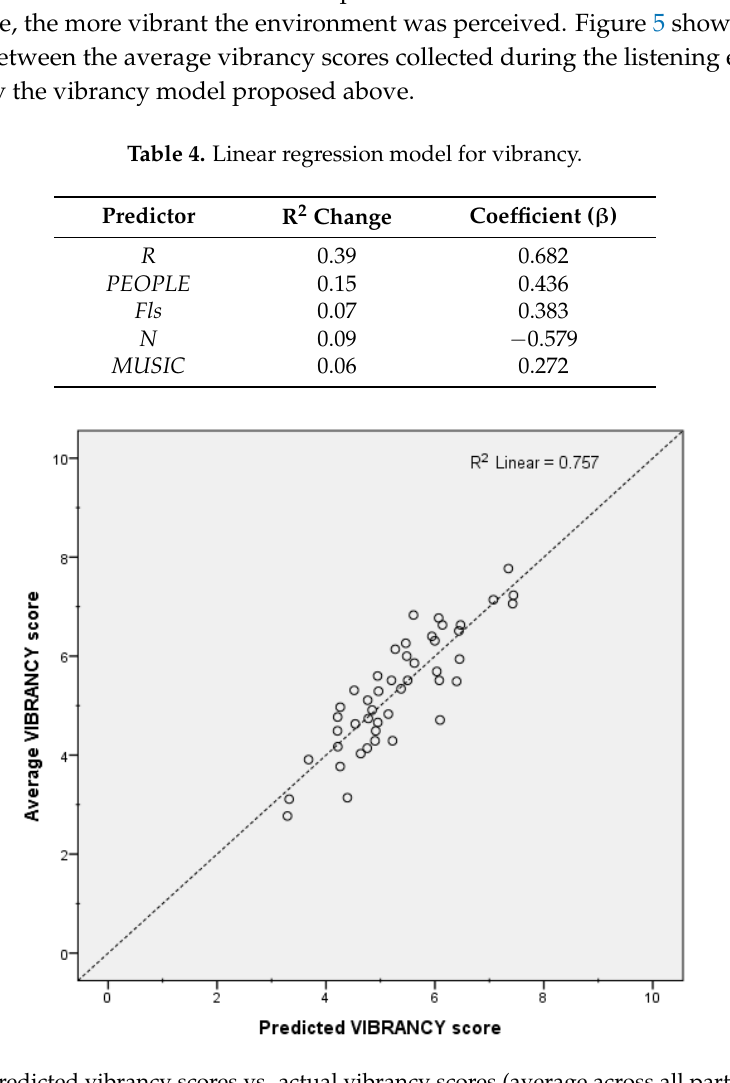
Figure 5. Predicted vibrancy scores vs. actual vibrancy scores (average across all